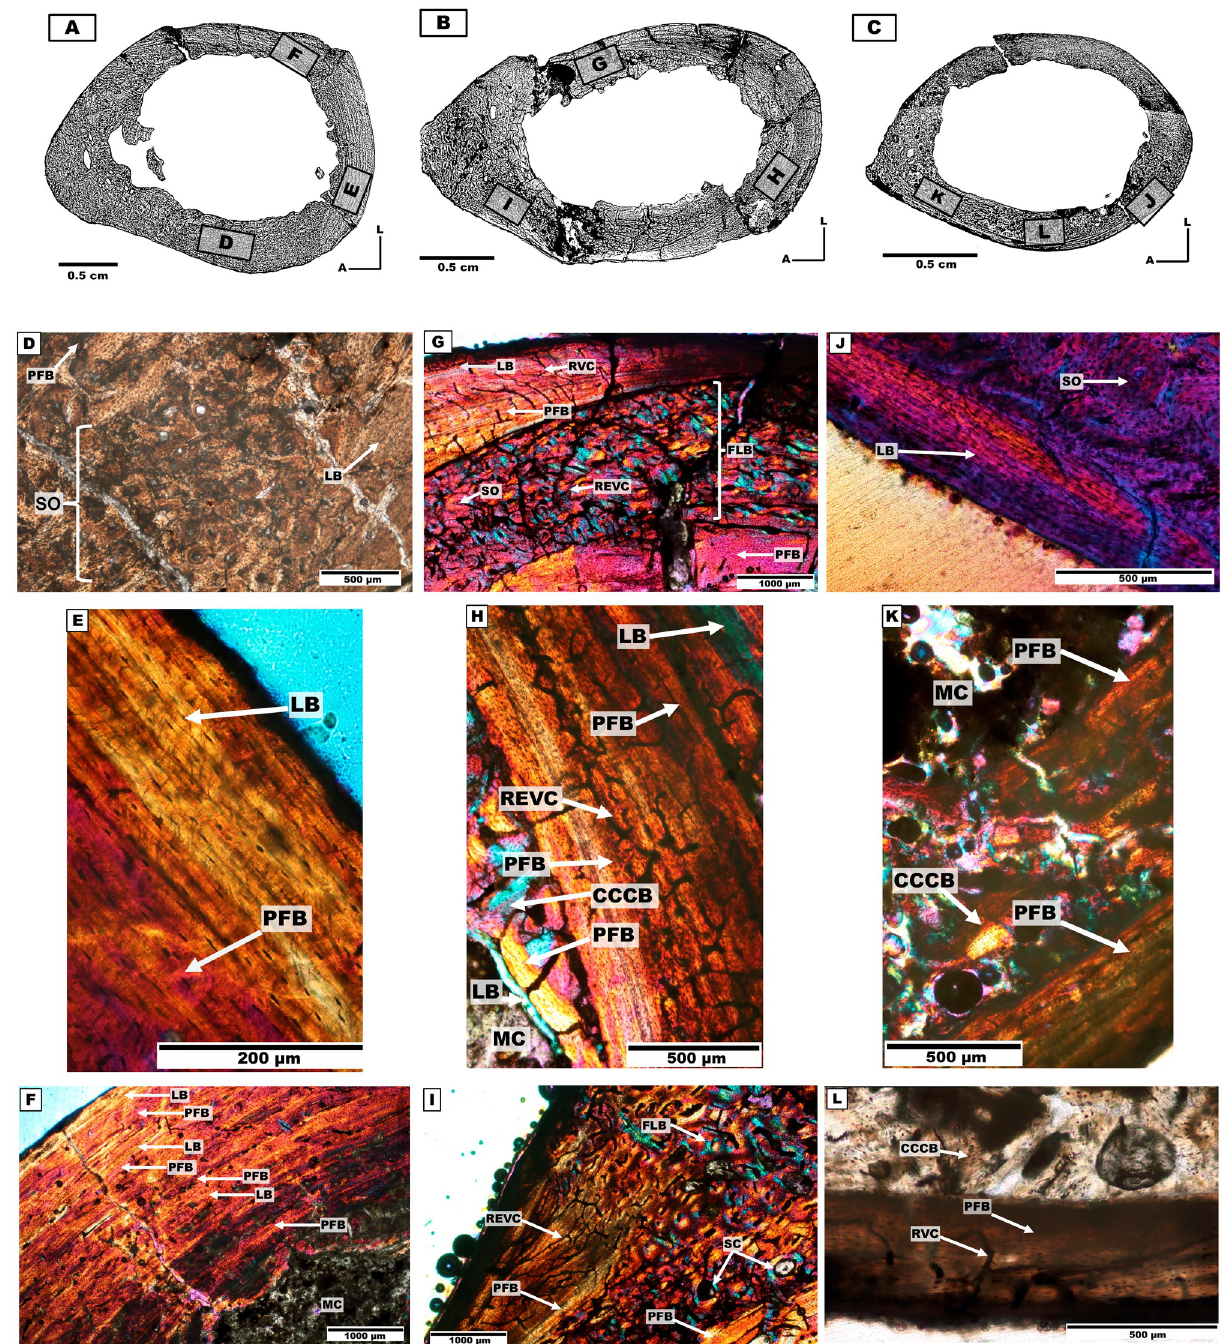
Fig 5. Distinct humerus cross-sections of the mesotheriine notoungulate Caraguatypotherium munozi from the middle Miocene of Caragua, Huaylas formation. (A) Humerus cross-section for individual 1 (GEOUACH.HS.HI.1); (B) Humerus cross-section for individual 2 (GEOUACH.HS. HD.1); (C) Humerus cross-section for individual 3 (GEOUACH.HI.2). (D) PFB in the endocortical region, SO in the intracortical region, LB in the pericortical region (GEOUACH.HS.HI.1); (E) PFB in the intracortical region and LB in the pericortical region (GEOUACH.HS.HI.1); (F) Intercalation of LB and PFB in the posterior area (GEOUACH.HS.HI.1); (G) Endocortical and pericortical region presence of LB and PFB, intracortical region presence FLB and SO (GEOUACH.HS.HD.1); (H) LB in the endocortical region, CCCB, PFB and LB in the intracortical region (GEOUACH.HS.HD.1); (I) Anterior area, FLB in the intracortical region, in the lateral area PFB and abundant vascularity (GEOUACH.HS.HD.1); (J) SO in the intracortical region, LB in the pericortical region (GEOUACH.HI.2); (K) PFB in the endocortical and pericortical region, CCCB in the intracortical region (GEOUACH. HI.2); (L) PFB in the pericortical region, RVC in this region open, in the intracortical region CCCB (GEOUACH.HI.2). For abbreviations refer to Fig 4.